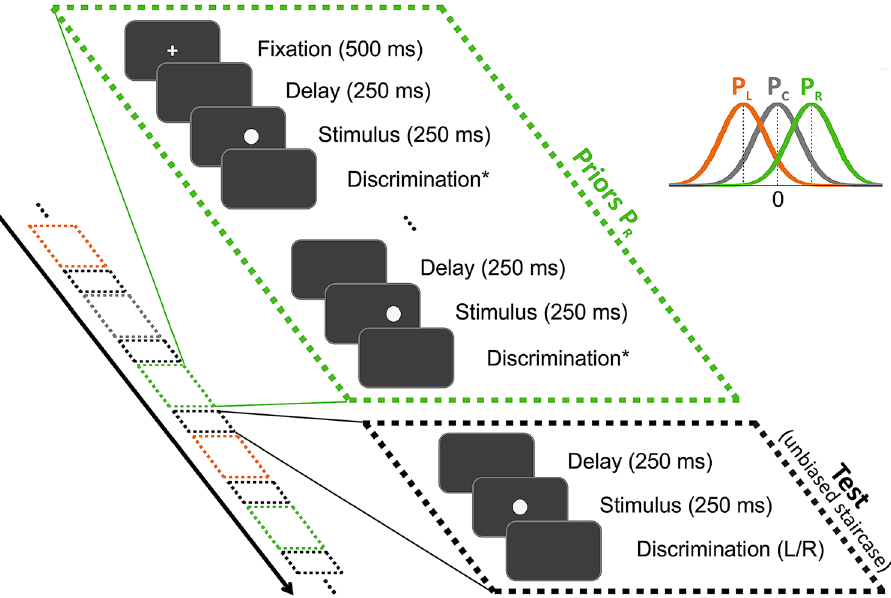
Figure 1. Event sequence within and across trials. Each trial began with a fixation point (at the screen center) followed by a series of discriminations of ‘prior’ stimuli (for example, priors biased to the right, green dashed boxes), and then discrimination of a single ‘test’ stimulus (black dashed boxes). The black arrow marks the time-course of the experiment, which interleaved trials of different prior types pseudo-randomly (right, left and center, marked by green, orange and gray boxes, respectively), each ending with a test stimulus (black box). The stimuli were circles on a dark gray screen, and were discriminated individually (in order). The discrimination task for the test circles was about location: was the circle to the left or to the right of the screen center? For the prior circles, the discrimination task (*) depended on the experimental condition. It was either location discrimination (like the test task) or color discrimination (unlike the test task). All discriminations required choosing one from two alternatives: right/left or green/purple (for location and color discrimination, respectively). Prior circle locations were drawn from a normal distribution and were either biased to the left or right of the screen center (orange and green probability distributions, P L and P R , respectively) or unbiased (center distribution P C , in gray). Test circle locations followed an unbiased staircase procedure.